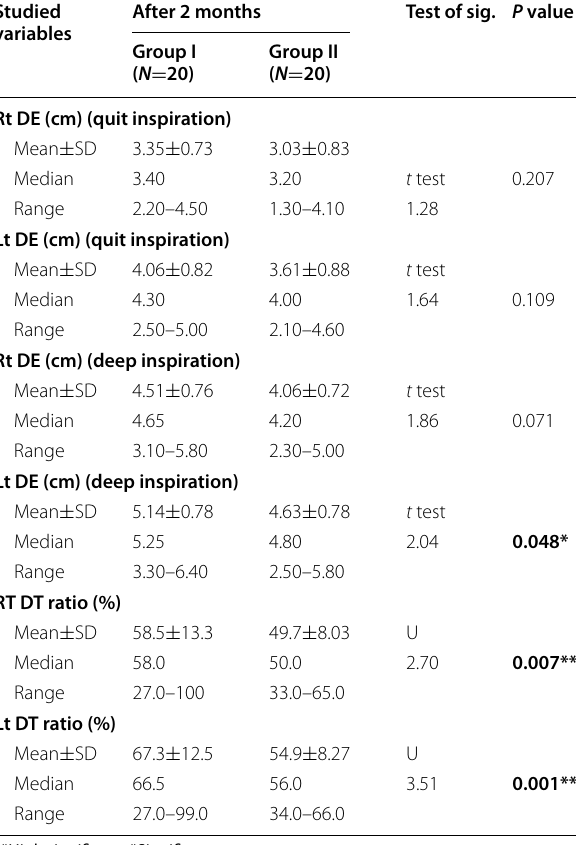
**High significant, *Significant